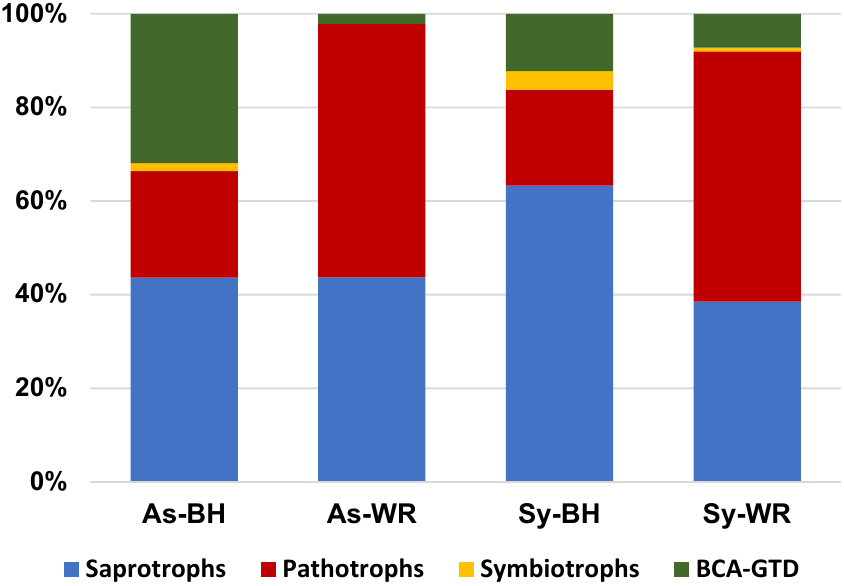
Figure 5. Relative abundance of trophic modes in wood samples. As-BH (foliar Esca asymptomatic vines with healthy or black necrosis in wood); As-WR (foliar Esca asymptomatic vines with white rot in wood); Sy-BH (vines with Esca foliar symptoms and healthy or black necrosis in wood); and Sy-WR (vines with Esca foliar symptoms and white rot in wood). Table 2. Percentage of carbon (C) and nitrogen (N) resulting from the grapevine wood samples.